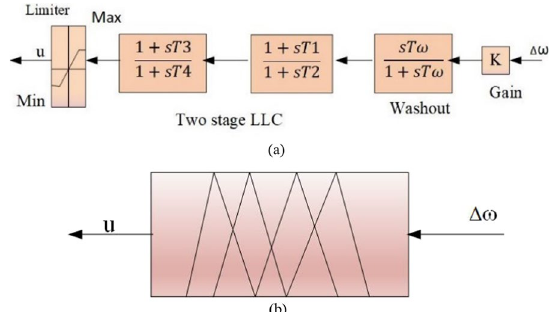
Fig. 8 a PSO optimized with lead-lag networks, b fuzzy controller